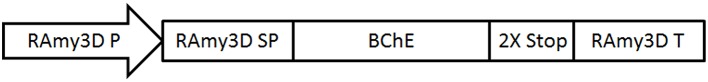
A schematic representation of the expression vector for butyrylcholinesterase (BChE) under control of the rice alpha amylase 3D expression cassette. RAmy3D P, rice alpha-amylase 3D promoter; RAmy3D SP, rice alpha-amylase signal peptide; BChE, codon optimized synthetic human BChE gene; RAmy3D T, rice alpha-amylase terminator.